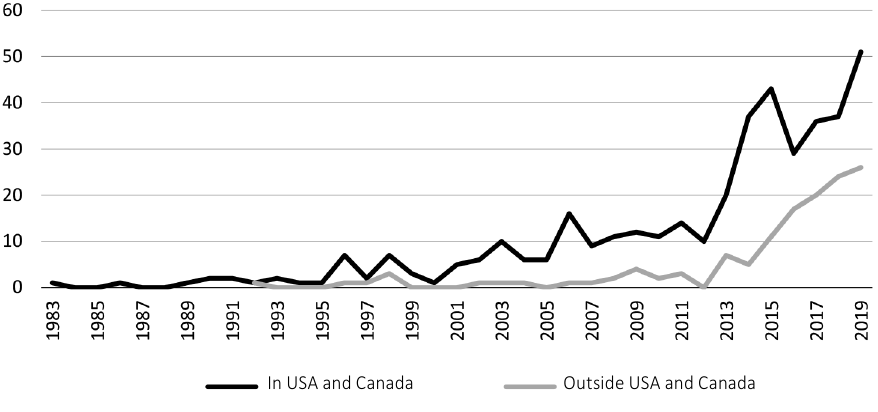
Figure 1. Number of new search funds established between 1983 and 2019